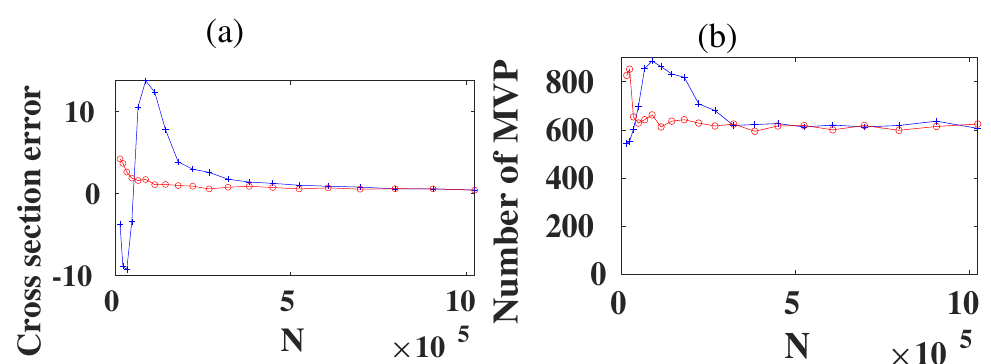
Figure 2. We study a sphere of radius r = λ and relative permittivity ε = 2.5. With crosses (and blue line) the computation is conducted with the classical DDA, i.e., with Equation (4) for the Green function and (14) for the polarizability, and with circles (and red line) DDA with the Filtered Green’s tensor. ( a ) Relative error in per cent on the extinction cross section between the computation conducted with the DDA and the Mie theory versus the number of subunit N . ( b ) Number of MVP needs to solve iteratively Equation (15) versus the number of subunit N .